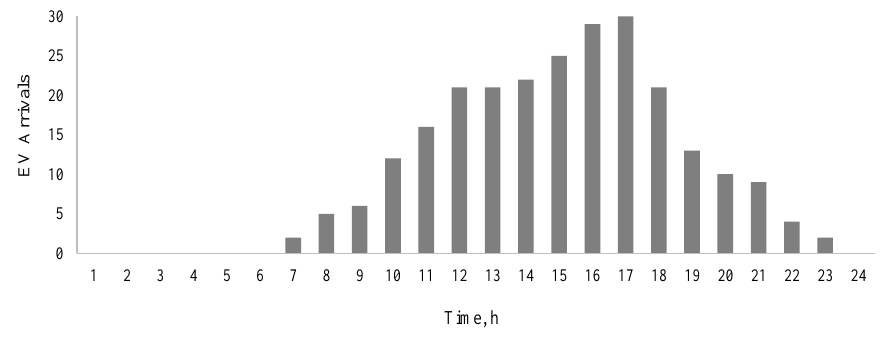
Figure 3. EV arrival rate within a typical day.